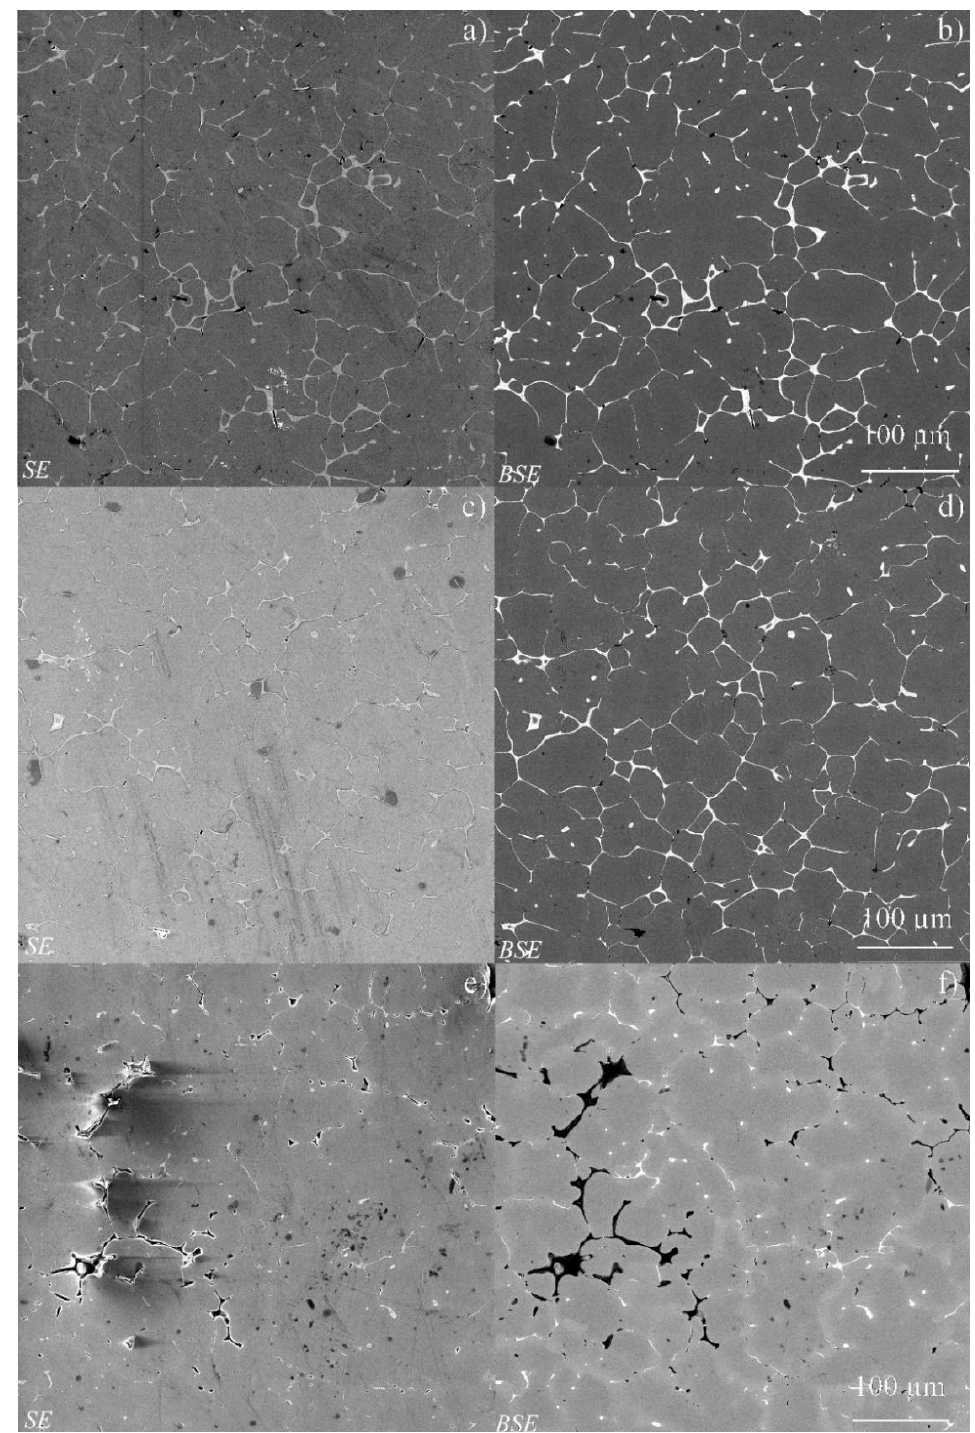
Figure 3. SEM images of the surface of magnesium alloy Mg–Ca–Zn reference ( a , b ), Mg–Ca–Zn–ND ( c , d ) and Mg–Ca–Zn US ( e , f